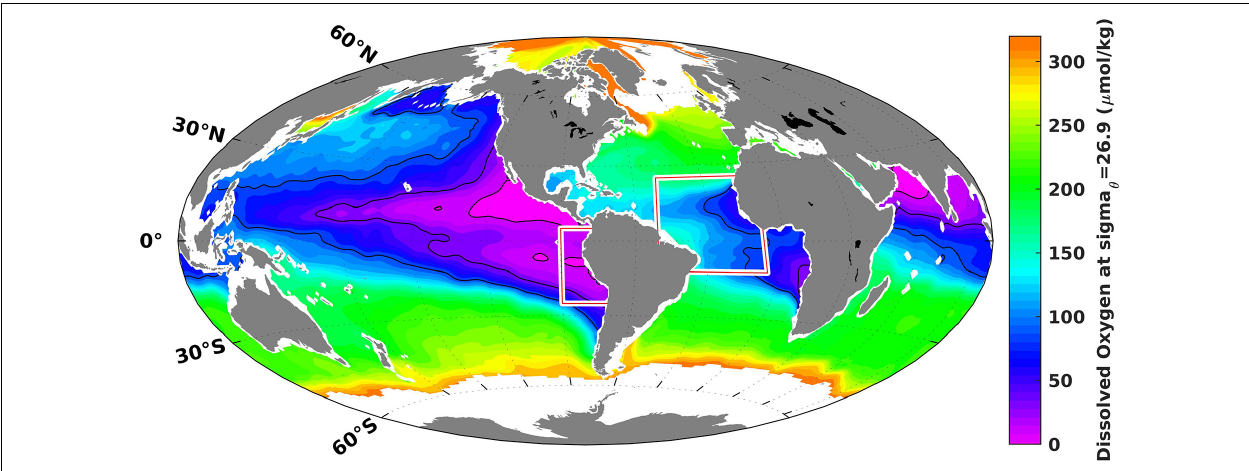
FIGURE 1 | The two working areas of the SFB 754 overlaid on the climatological content of dissolved oxygen on the potential density surface sigma θ 26.9 (between 200 and 500 m depth in tropical regions). The map is based on data from the World Ocean Atlas 2018 (Garcia et al.,